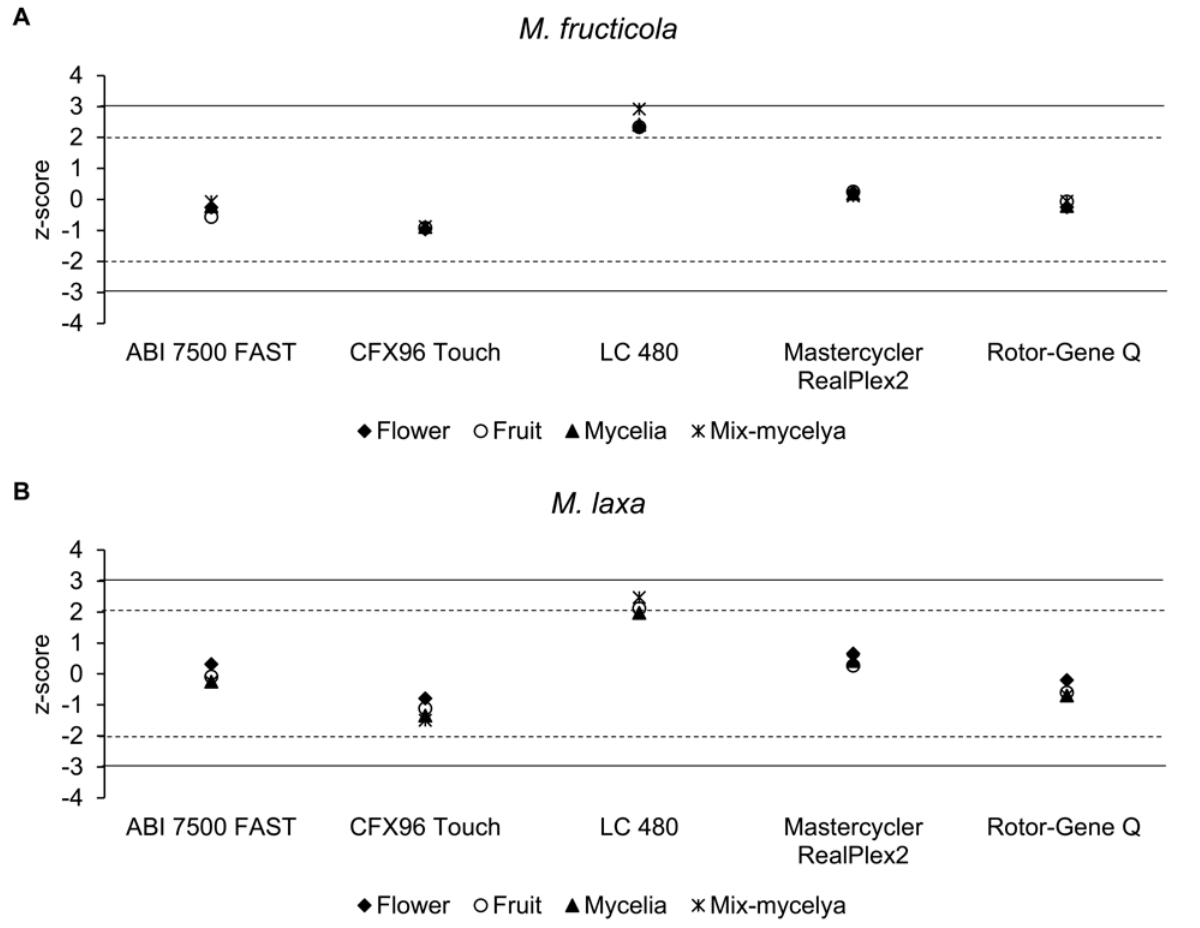
Figure 1. Z -scores for the detection of different Monilinia fructicola (A) and M. laxa (B) samples with P_fc and P2_fgn/lx/ps hydrolysis probes, for each of five laboratories. Z- scores between 2 and -2 are acceptable (dotted line), those greater than 3 or lower than -3 are unacceptable (solid line) and those between the lines need to be